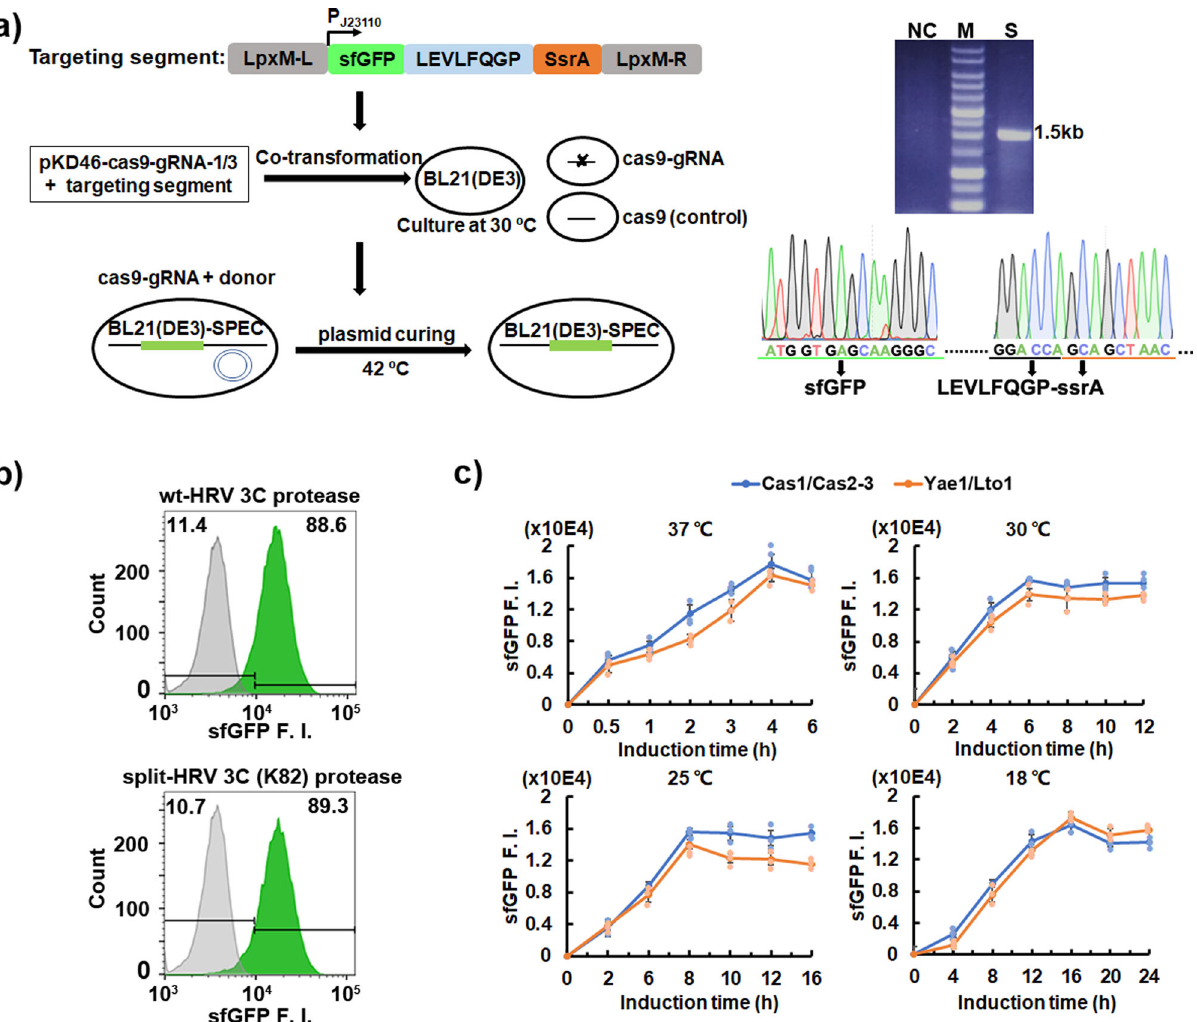
Fig. 3 Development of SPEC system in the engineered BL21(DE3)-SPEC cells. a Generation of the BL21(DE3)-SPEC cells using no-SCAR incorporated with temperature sensitive plasmid curing strategy. Left panel, scheme of experimental procedure. The lpxM gene fragment in the genome of BL21(DE3) strain is replaced by sfGFP-LEVLFQGP-SsrA fragment using CRISPR/Cas9 assisted λ -Red recombinase technology. The pKD46 based vector is used to prompt the temperature sensitive plasmid curing. Upper-right panel, PCR validation of the inserted sfGFP-LEVLFQGP-SsrA fragment in BL21(DE3)-SPEC strain. Negative control (NC): wild-type BL21(DE3) strain. S: BL21(DE3)-SPEC strain. M: 1Kb DNA ladder. Lower-right panel, Sanger sequencing of BL21 (DE3) genome to verify the insertion of the sfGFP-LEVLFQGP-SsrA fragment. b Validation of the SPEC system in the BL21(DE3)-SPEC strain by comparing the HRV 3 C protease (pSPEC-VB) and split HRV 3 C (K82) protease (pSPEC-VC1) with Cas1/Cas2-3 protein pair. The experiments were